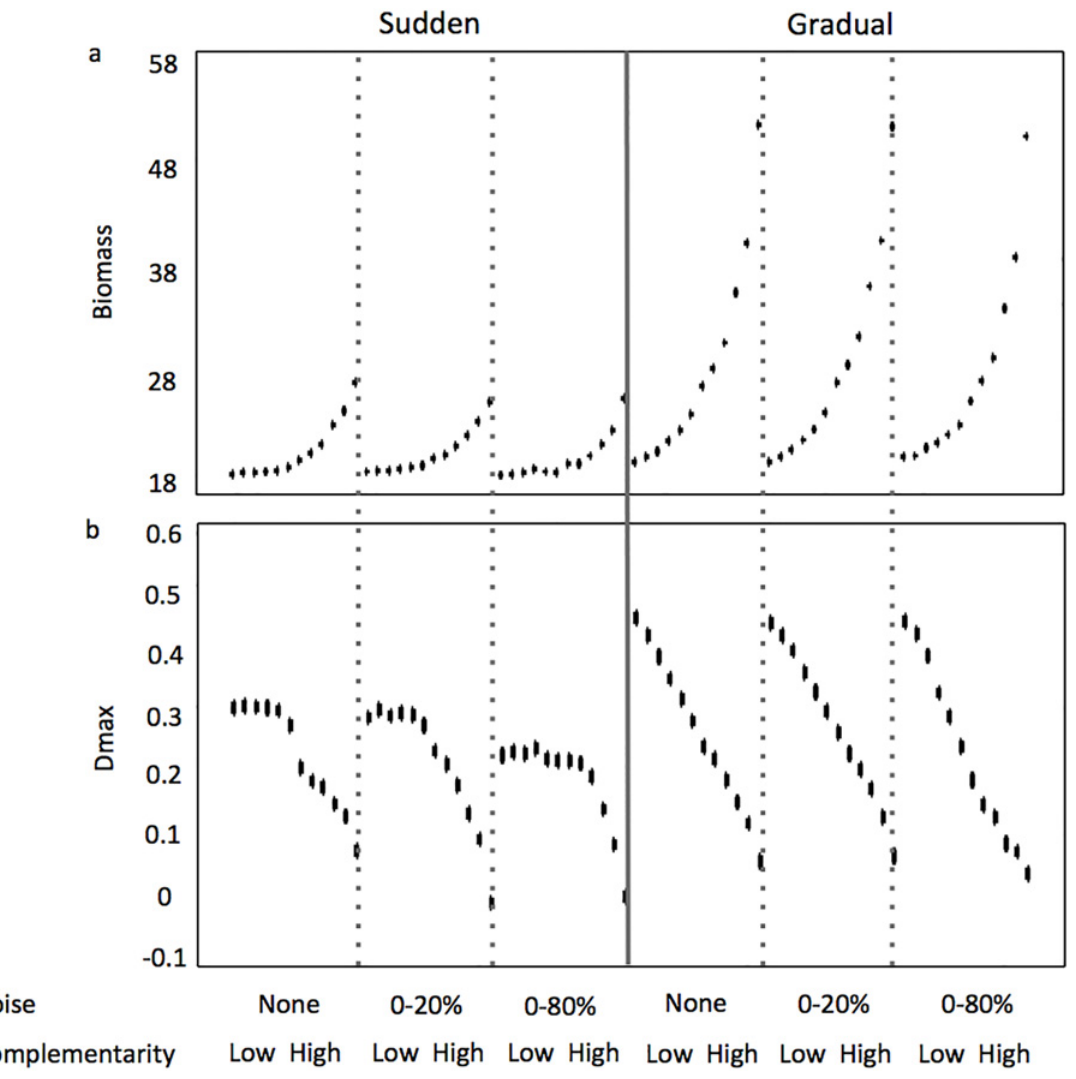
Fig 7. Variability of Biomass (a sum of co-existing populations ’ cell density, in units of x10 6 cells liter -1 ) (a) and transgressive overyielding index Dmax (b) along a gradient of increasing complementarity in the assemblages and noise in resource concentration from the supply, when the reversal in resource supply concentrations is sudden and gradual. Error bars represent 95% confidence